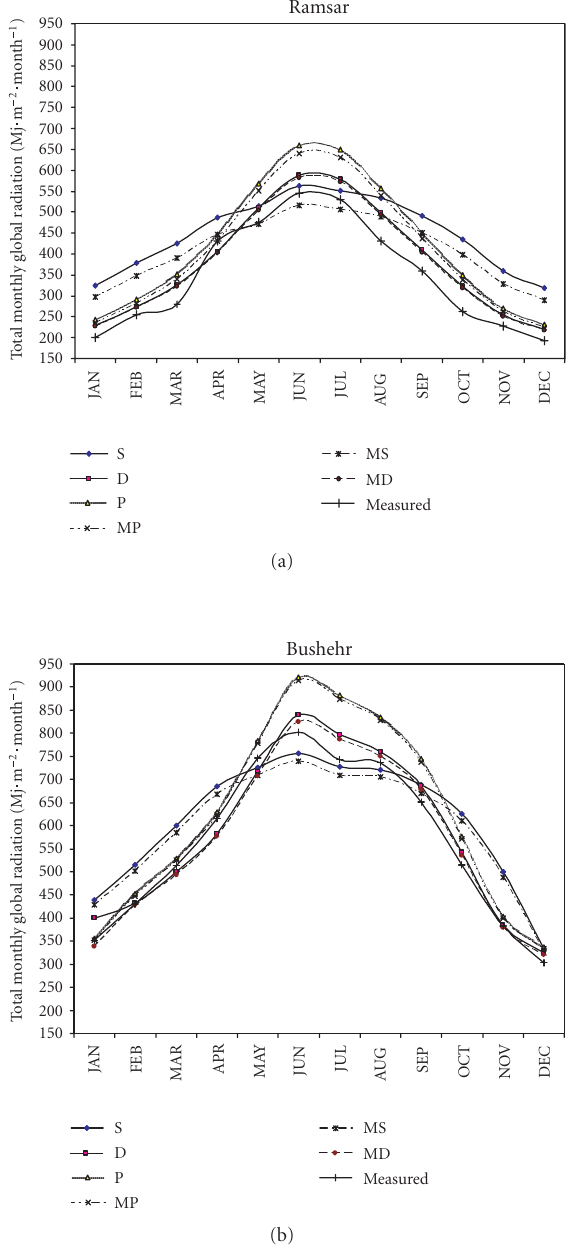
Figure 1: Comparison of the measured and predicted total monthly m (cid:3) 2 month (cid:3) 1 ) on a horizontal surface for: global radiation (Mj (cid:2) (cid:2) (a) Ramsar [North] and (b) Bushehr